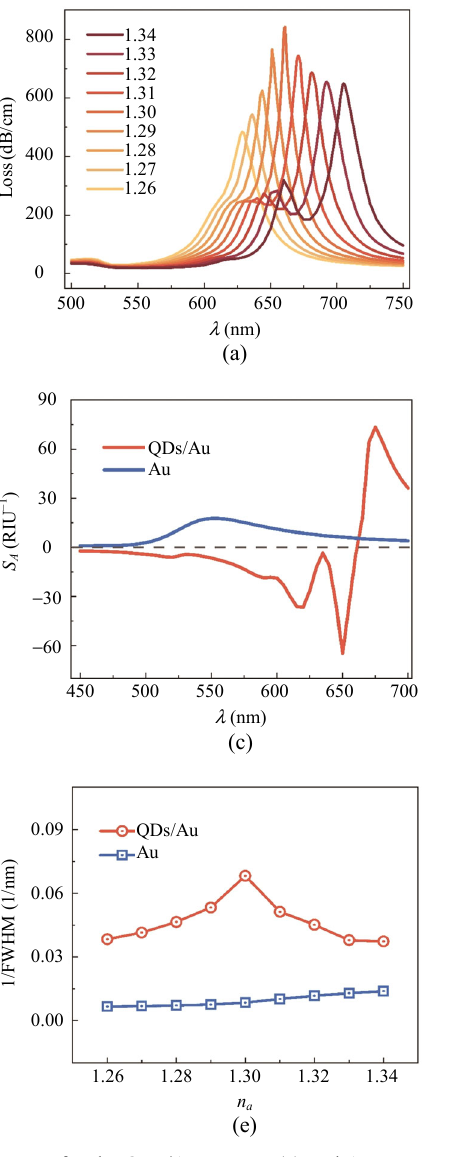
Fig. 2 Loss spectra for the QDs/Au sensors (a) and Au sensors (b) with different n a and the performance comparisons: (c) amplitude sensitivity with n a = 1.30, (d) wavelength sensitivity, (e) 1/FWHM, and (f)